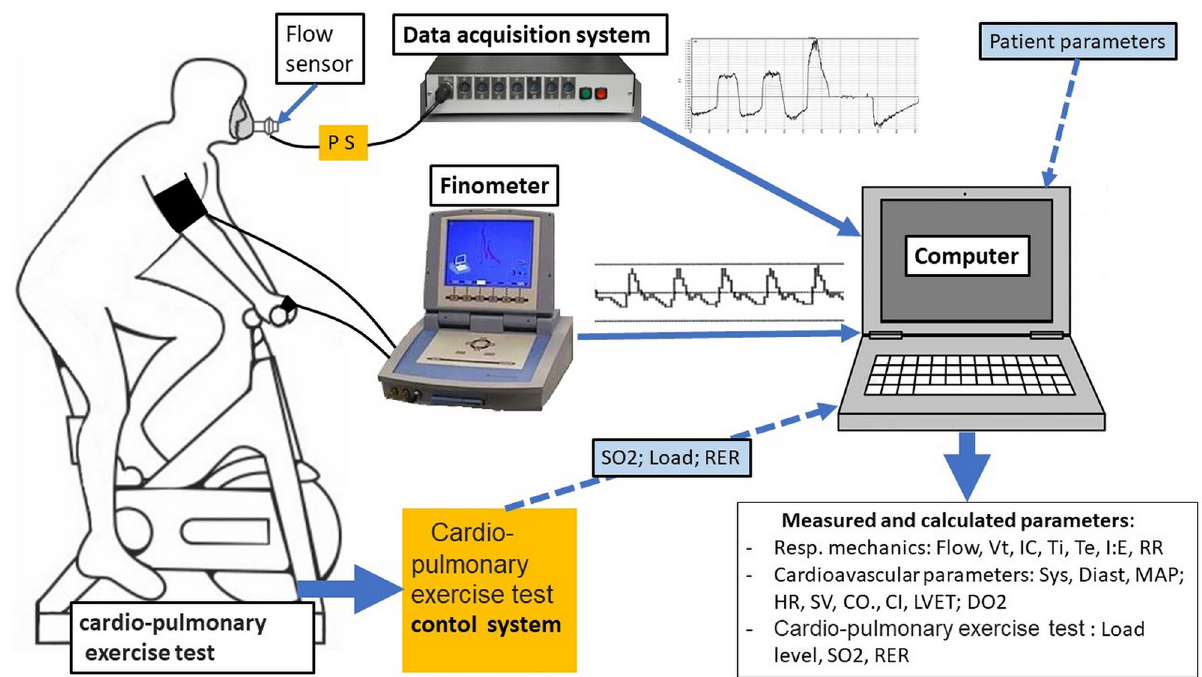
Fig 1. Experimental set-up. On-time complex assessment of the exercise physiologic parameters, respiratory flow and systemic circulation. PS: pressure sensor; Flow: respiratory flow; VT: tidal volume; IC: inspiratory capacity; Ti: inspiratory time; Te: expiratory time; I:E: inspiraton/expiration ratio; RR: respiratory rate; Sys: systolic blood pressure; Diast: diastolic blood pressure; MAP: mean arterial pressure; HR: heart rate; SV: stroke volume; CO: cardiac output; CI: cardiac index; LVET: left ventricular ejection time; DO 2 : oxigen delivery; SO 2 : oxigen saturation; RER: respiratory exchange